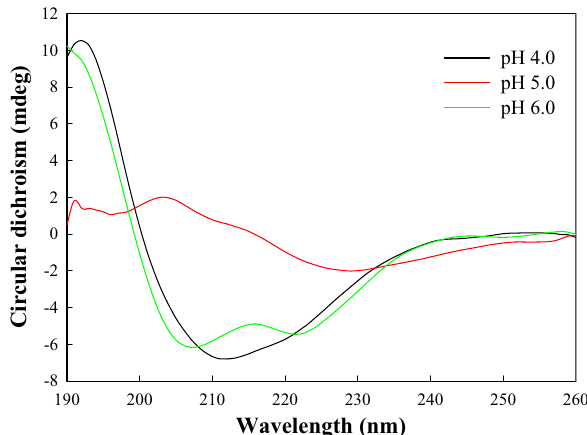
Figure 6. Far-UV CD spectra of SnuCalCpI03 at pH 4.0, 5.0, and 6.0 13 .